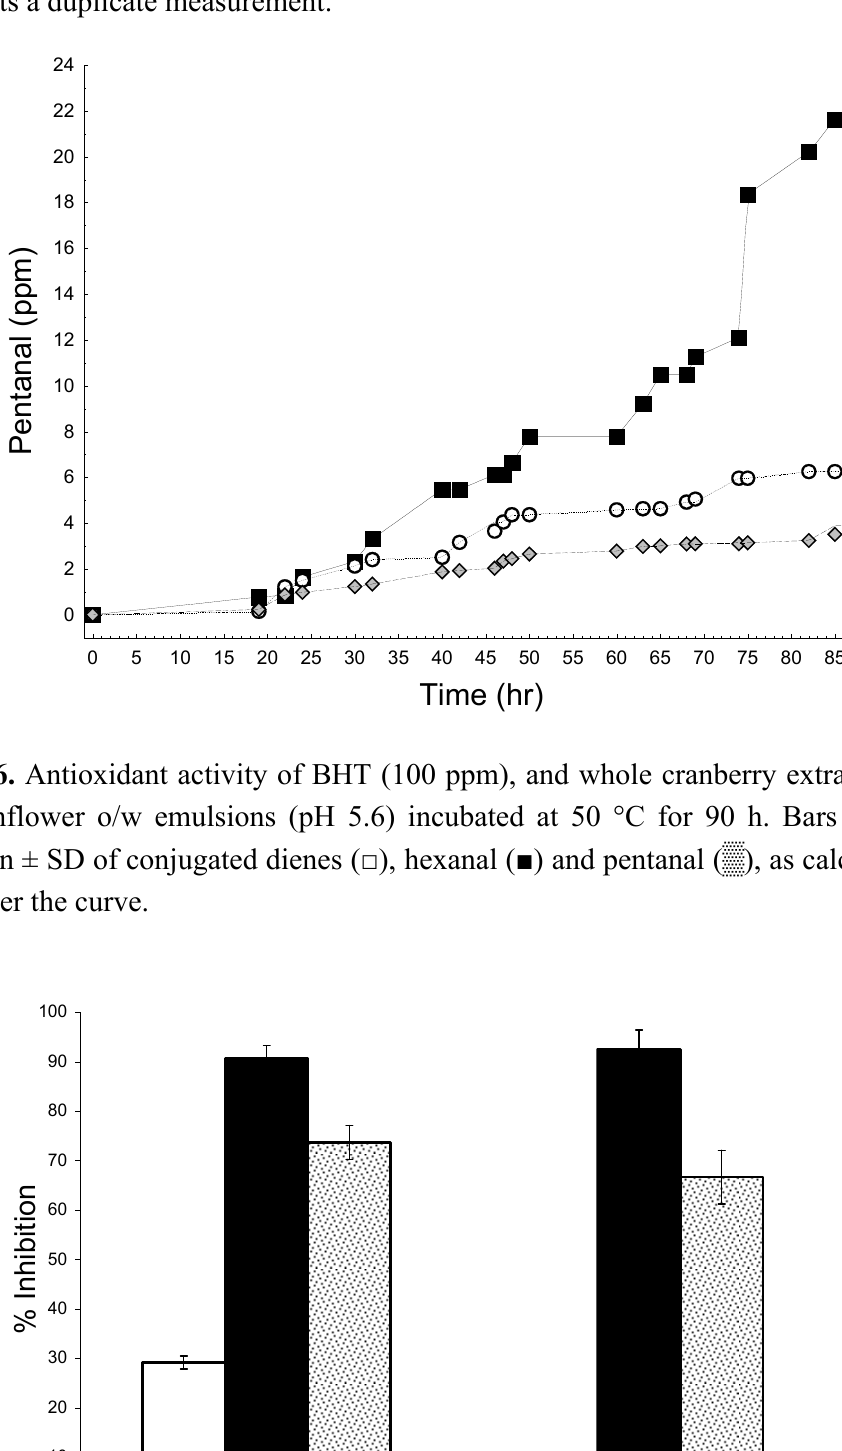
Figure 5. Production of pentanal in sunflower o/w emulsions during oxidation in the dark at 50 °C for control emulsion ( ■ ), emulsion containing whole cranberry extract (WCE) ( ○ ), and emulsion containing 100 ppm butylated hydroxytoluene (BHT) ( ◊ ). Each point represents a duplicate measurement.